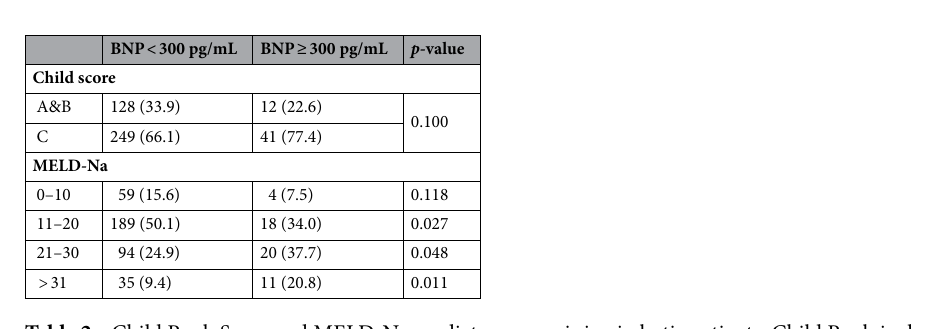
Table 2. Child Pugh Score and MELD-Na predicts prognosis in cirrhotic patients. Child Pugh includes- bilirubin level, albumin, INR, encephalopathy, ascites. MELD Na includes- Bilirubin, dialysis, Creatinine, Sodium, INR. Higher scores correlate with increased